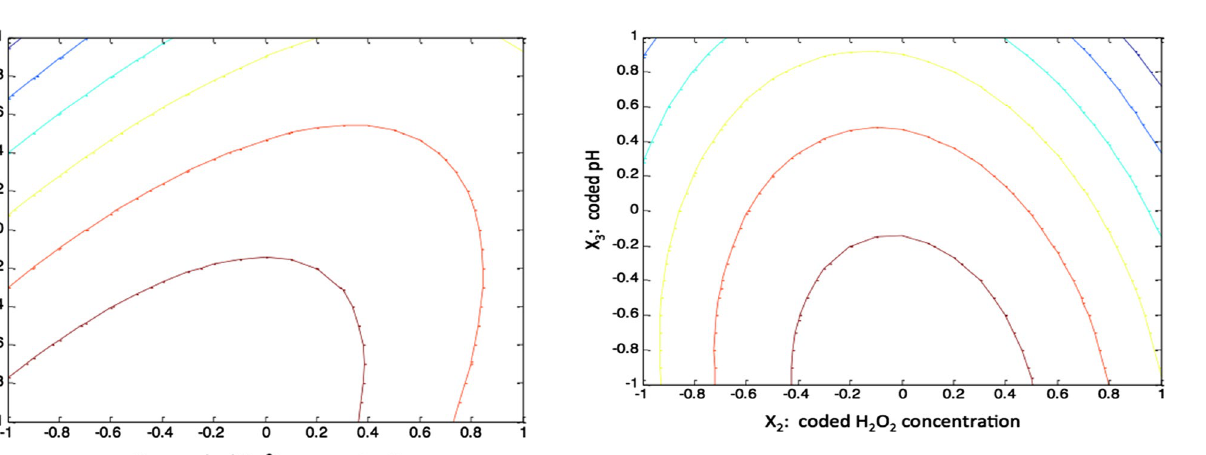
Fig. 6 Contour plot of dye removal showing interaction of Fe 3+ dos- age and pH